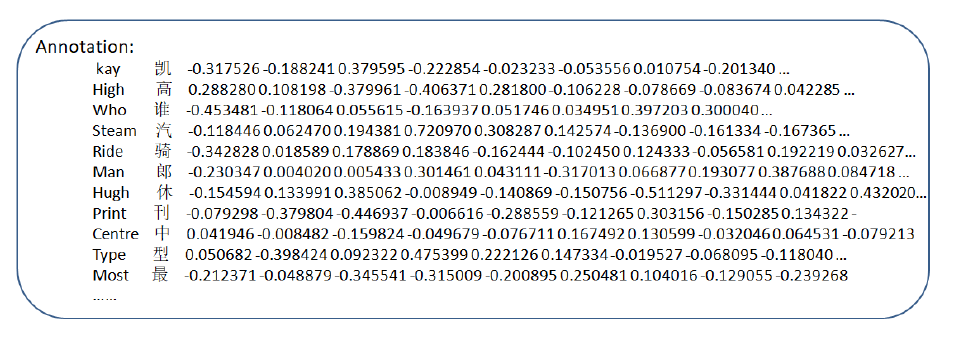
Figure 4. Word embedding